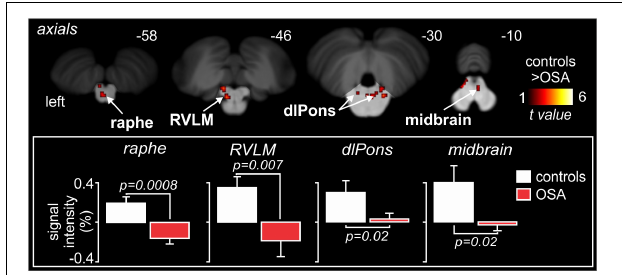
FIGURE 9 | Brainstem regions in which MSNA-coupled BOLD signal intensity was significantly different in OSA and controls. Signal intensity increased in controls but decreased in OSA. Reproduced, with permission, from Lundblad et al.